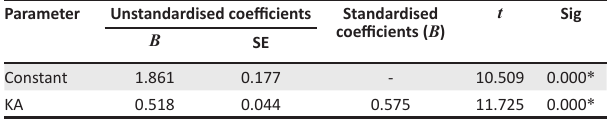
TABLE 12: Parameter estimates for the knowledge sharing on small and medium enterprises’ innovation capabilities